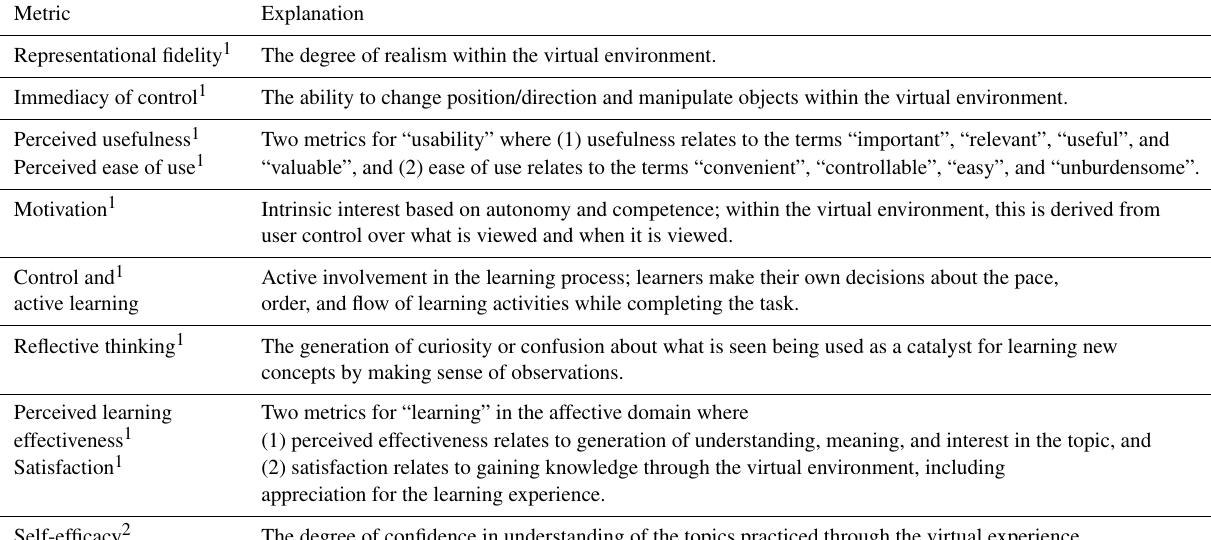
Table 1. Metrics from the participant questionnaire and their respective explanations. Metric